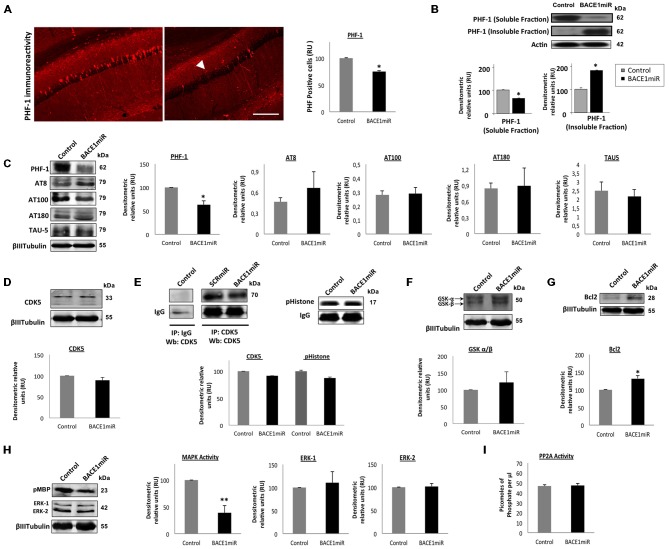
BACE1miR reverses hyper-phosphorylated tau in the hippocampus of 3xTg-AD mice. (A) The number of PHF-positive cells in the CA1 region of the hippocampus of 18-month-old 3xTg-AD mice that were treated with AAV2/5-BACE1miR or AAV2/5-GFP as control for 6 months. The white arrowhead shows a significant decrease in immunoreactivity. Representative confocal-DSU images ofimmunofluorescence are shown. Red: Alexa 594, 10× magnification, scale bar: 20 μm. n = 3, *p < 0.05. (B) Representative bands of the soluble and insoluble fractions of tau. n = 3, *p < 0.05. (C) Levels of the hyperphosphorylated tau (PHF-1, AT8, AT100, AT180 and TAU-5) protein from the hippocampi of 18-month-old 3xTg-AD mice at 6 months after injection with AAV2/5-BACE1miR or AAV2/5-GFP as control. Representative blots are shown. RU = relative units. n = 4, *p < 0.05. (D) CDK5, (E) CDK5 activity, (F) GSK3- β, (G) Bcl-2, (H) MAPK activity and ERK-1/ERK-2 protein levels were detected. (I) Protein phosphatase 2 (PP2A) activity was quantified using the PP2A Immunoprecipitation (IP) Phosphatase Assay Kit (Millipore), which detects picomoles of phosphate per microliter. n = 4, *p < 0.05. Representative blots are shown. RU = relative units. n = 4, *p < 0.05, **p < 0.001.